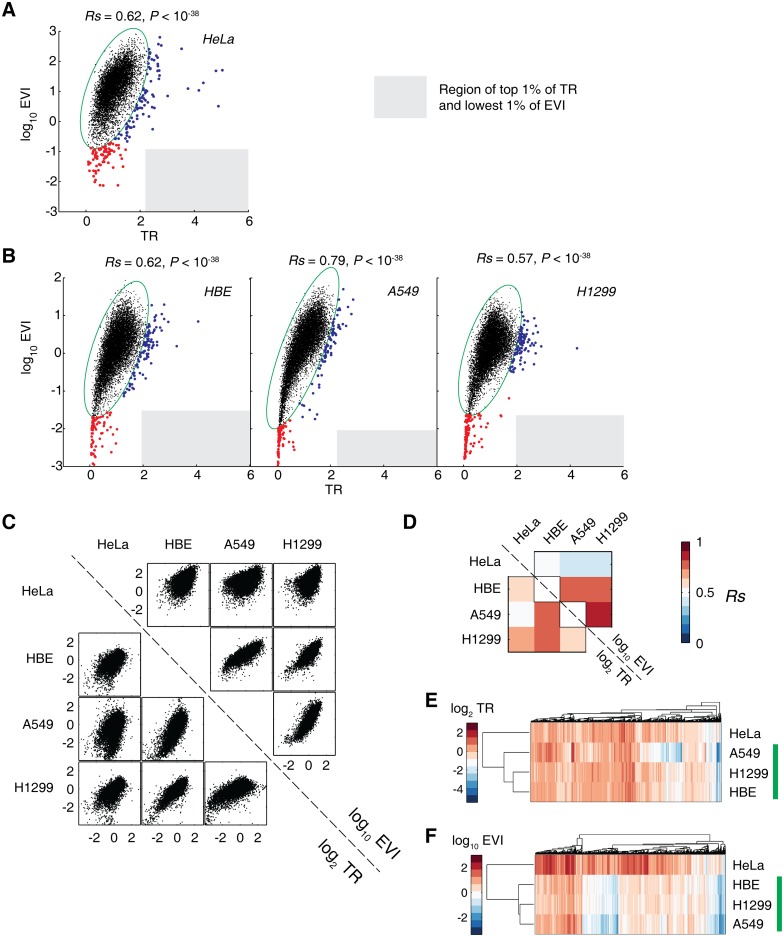
Two mutually exclusive and polarized translation control modes.(A) The TR and EVI of genes in HeLa cells. The green ellipse indicates the 95% confidence ellipse. Genes outside of this ellipse were clustered in two major clusters (red and blue dots) based on their Euclidean distances. The grey region denotes the region with high TR (genes with top 1% TR) and low EVI (genes with lowest 1% EVI), simultaneously. Rs = Spearman R. (B) The TR and EVI of genes of HBE, A549 and H1299 lung cell lines, respectively. (C) Plot matrix of mutual correlation of the TR (lower half triangle) and EVI (upper half triangle) among the four analyzed cell lines. (D) The heatmap of the Spearman R of the panel (C). All of the P-values are less than 10−38. (E,F) Cluster analysis of the TR (E) and EVI (F) of the four cell lines. The lung-derived cell lines are indicated by a green bar.